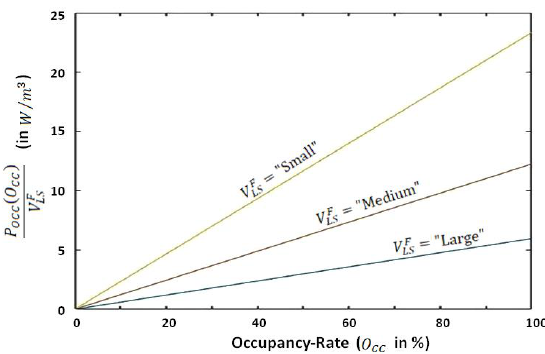
( O CC ) (𝑂 𝐶𝐶 ) Figure 10. P OCC (introduced in Equation (5) of the second section) versus the occupancy rate Figure 10. 𝑃 𝑂𝐶𝐶 (introduced in Equation (5) of the second section) versus the occupancy rate for V F 𝑉 𝐿𝑆𝐹 LS the three considered categories of living spaces of Building A.